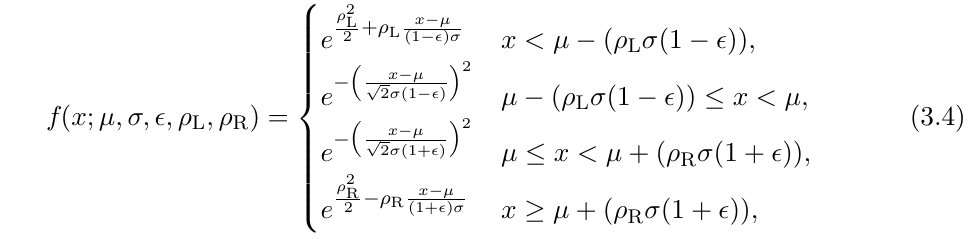
Figure 2 . The (left) M ( K (cid:7) (cid:25) (cid:6) ) and (right) log inclusive D 0 mesons in the backward data sample in the kinematic range of 2 < p T < 3 GeV =c